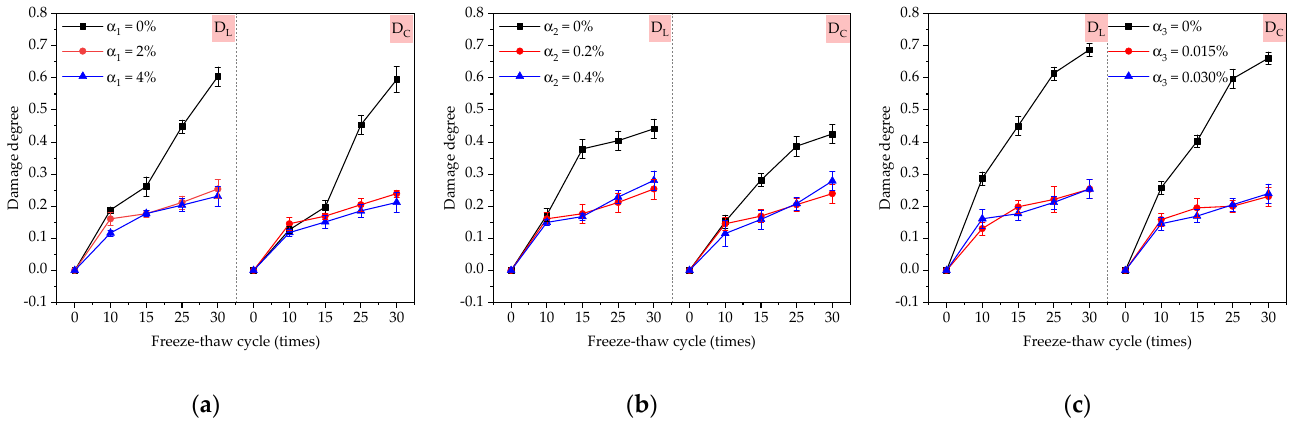
Figure 3. Influence of three factors on damage degree: ( a ) the factor of redispersible emulsion powder; ( b ) the factor of polypropylene fiber; ( c ) the factor of air-entraining agent. D L : damage degree measured by transverse fundamental frequency; D C : damage degree measured by supersonic velocity.